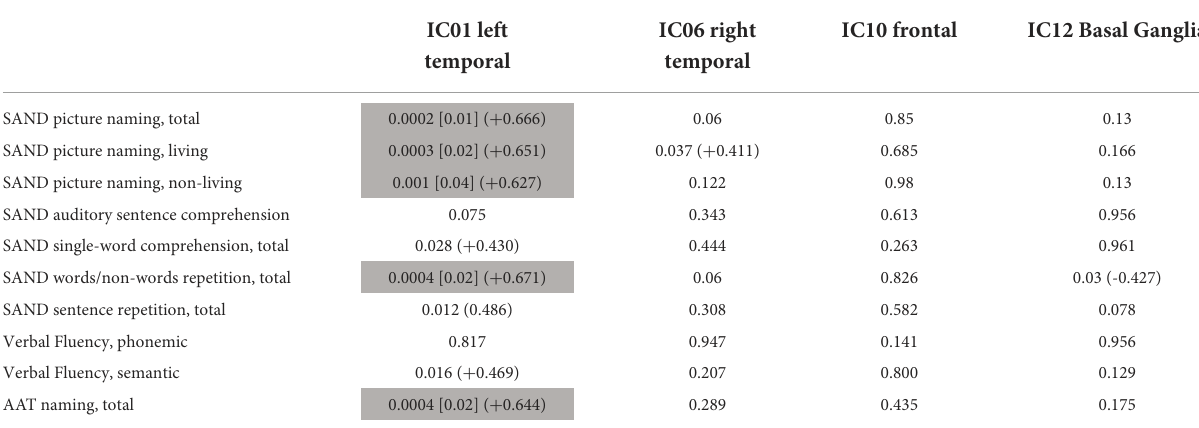
TABLE 3 Partial correlation analysis in avPPA between language tests and SBM